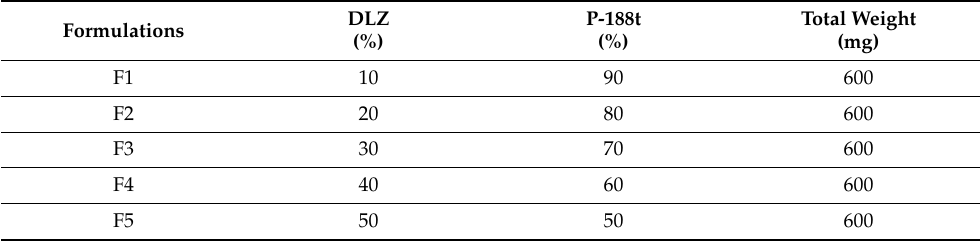
Table 1. Controlled release polymer matrices containing various drug to polymer percentages.